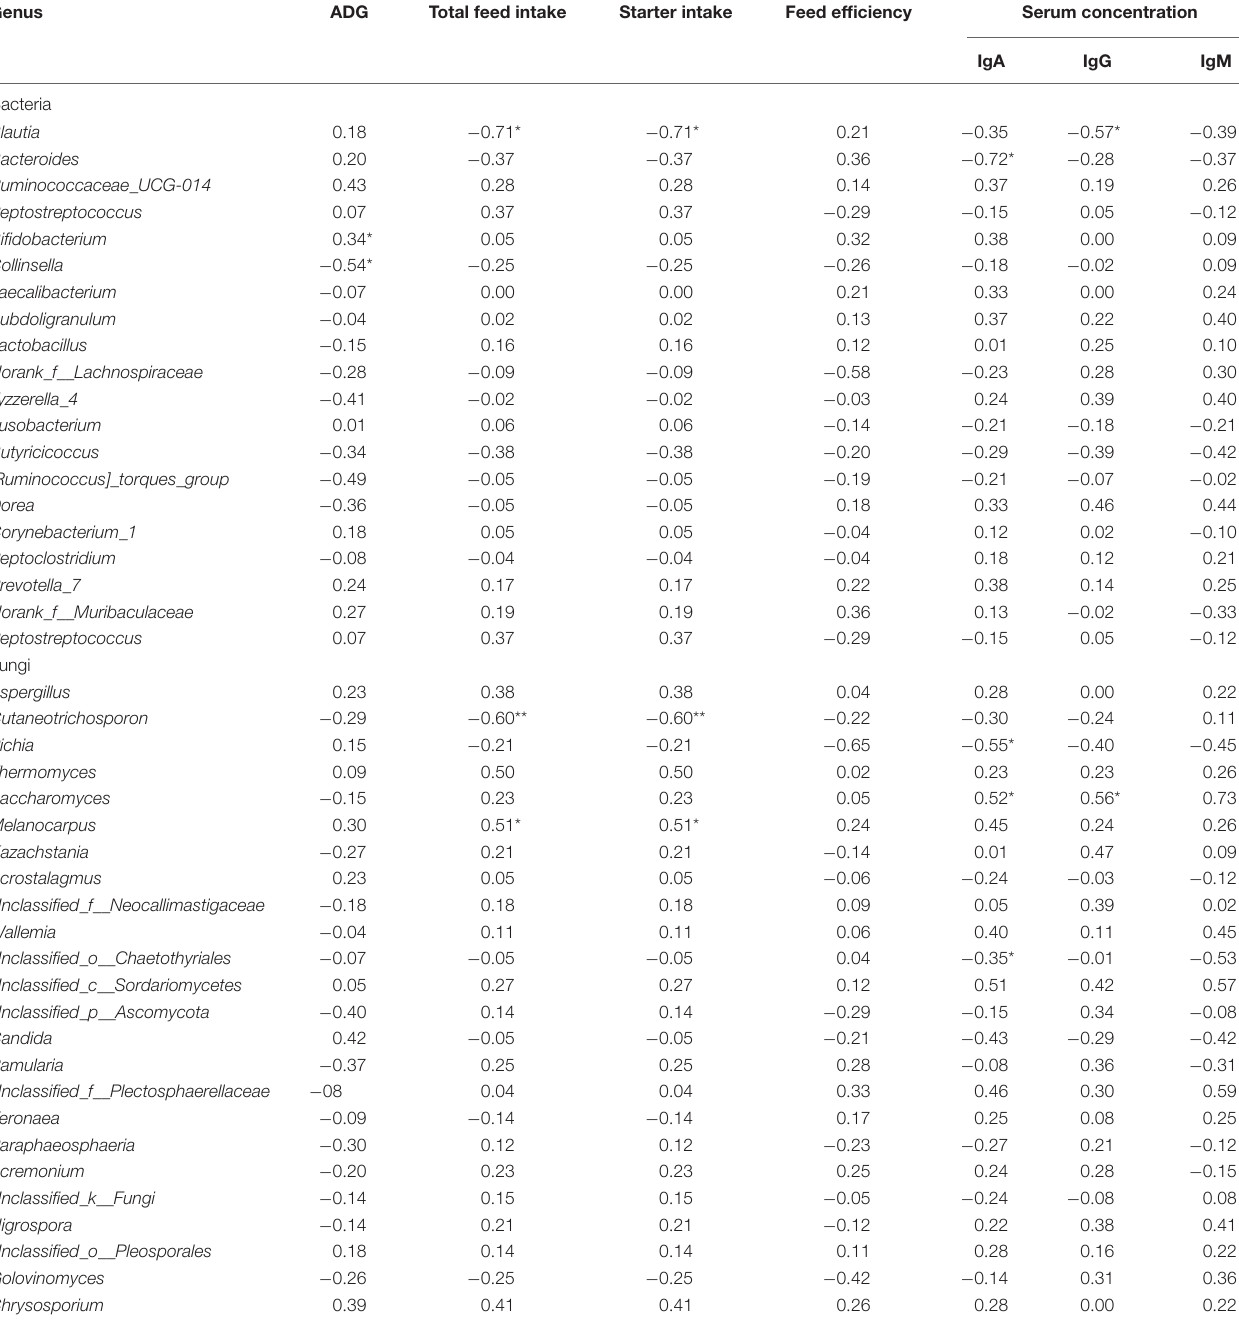
TABLE 6 | Pearson correlation coefficients between the populations of the principal genera at WK 2 and immunoglobulin indices. Genus ADG Total feed intake Starter intake Feed efficiency Serum